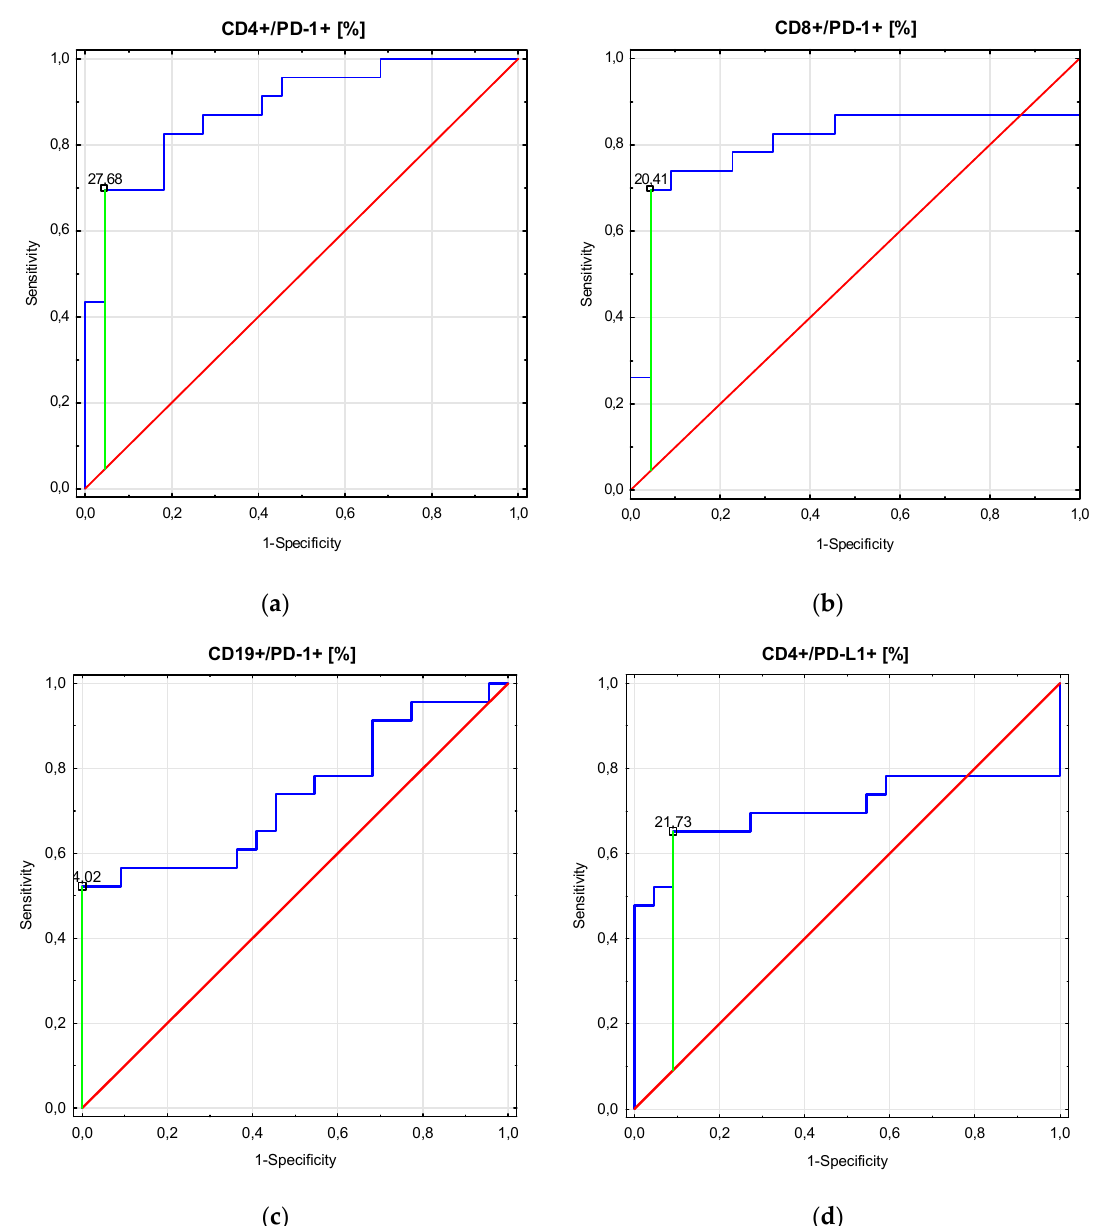
Figure 2. Receiver operating curve (ROC) analysis to determine diagnostic accuracy in differentiation of patients with proliferative glomerulonephritis (PGN). ( a ) CD4+/PD-1 (%); ( b ) CD8+/PD-1 (%); ( c ) CD19+/PD-1 (%); ( d ) CD4+/PD-L1 (%).